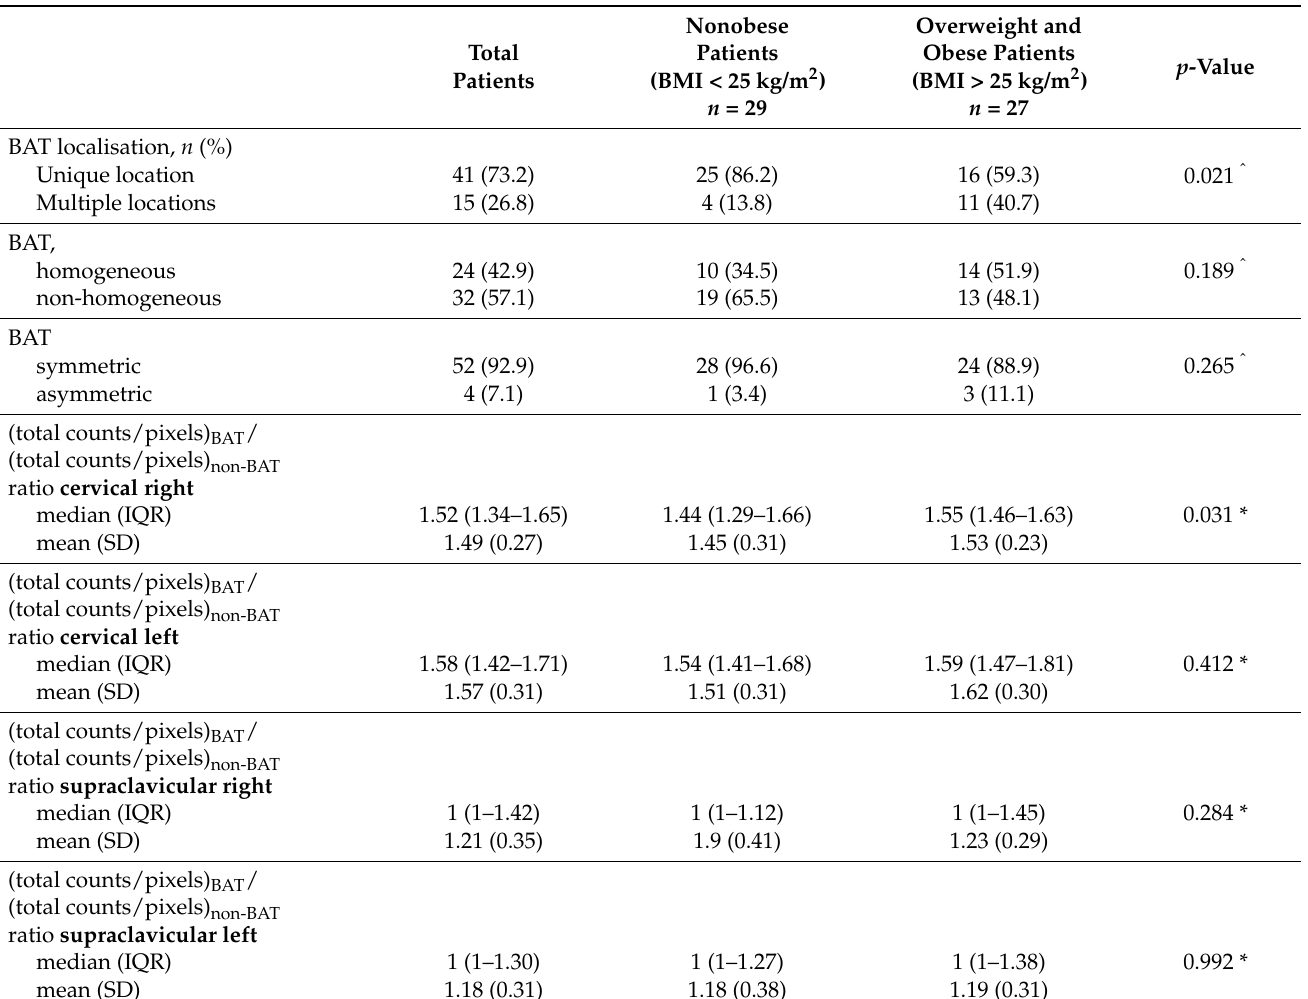
Table 2. BAT pattern and